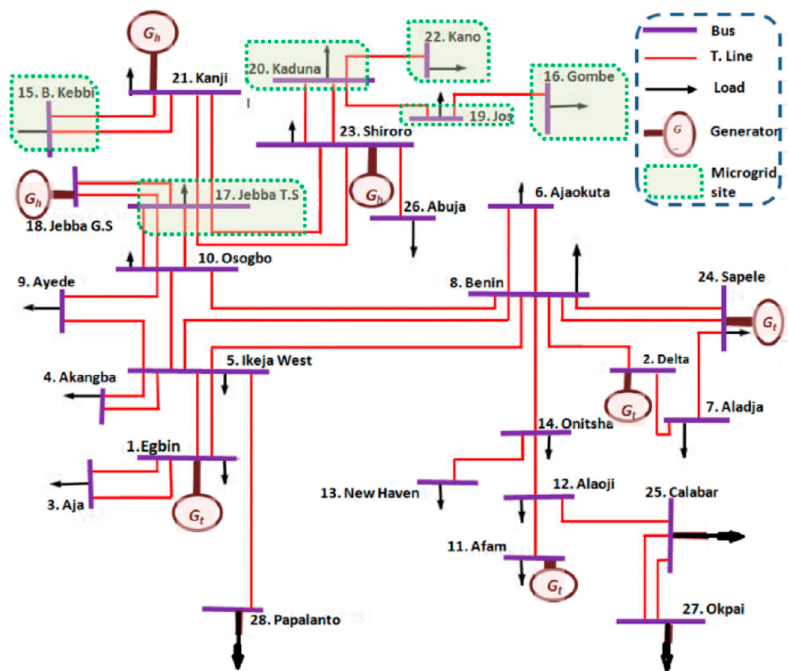
Figure 11. Nigerian power system with highlighted microgrid site and other PV solar farm sites [131].